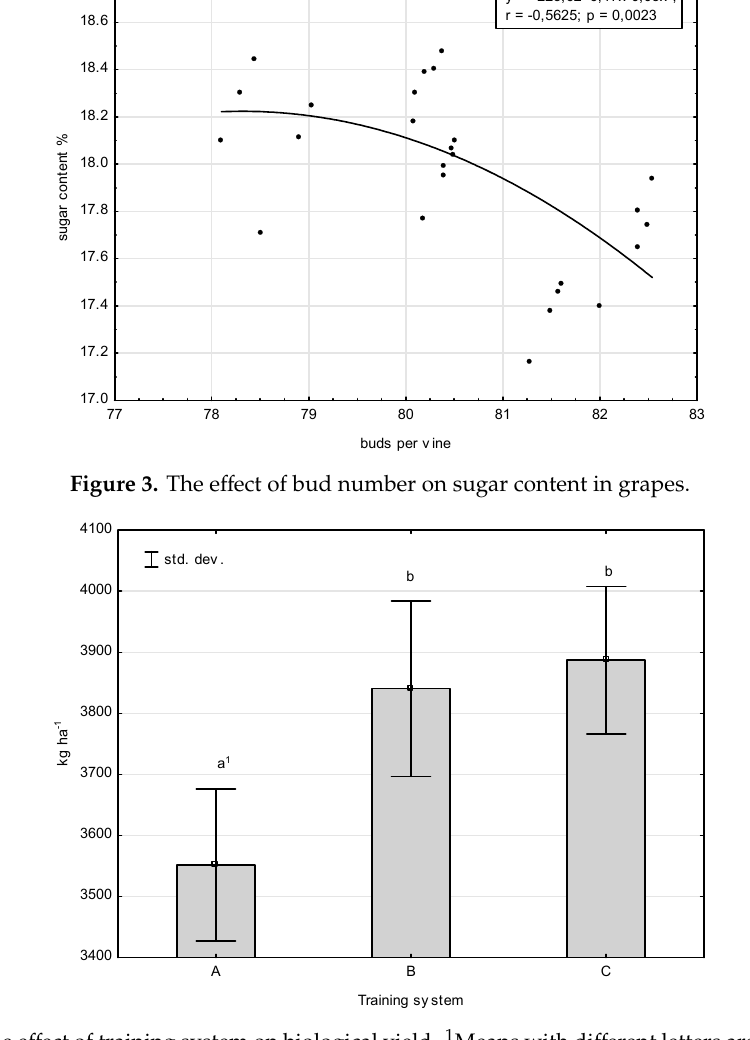
Figure 4. The effect of training system on biological yield. 1 Means with different letters are significantly different, according to Tukey test ( p ≤